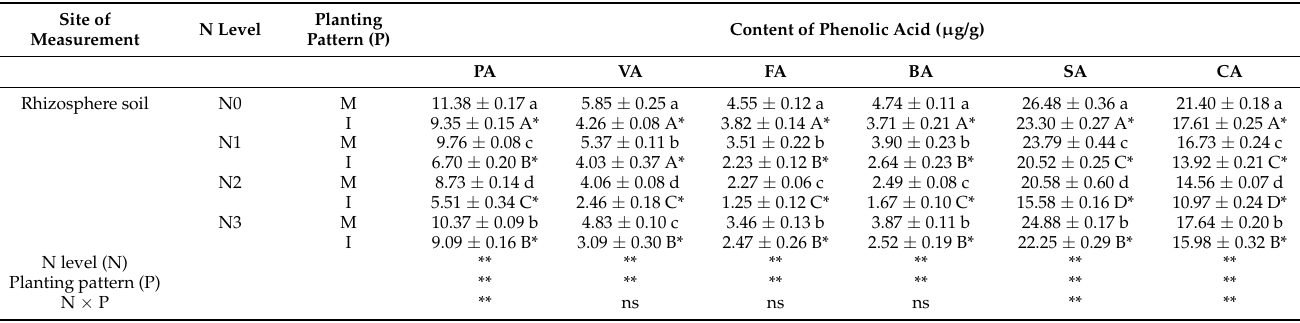
Table 5. Effects of nitrogen application and intercropping on phenolic acid content in faba bean rhizosphere